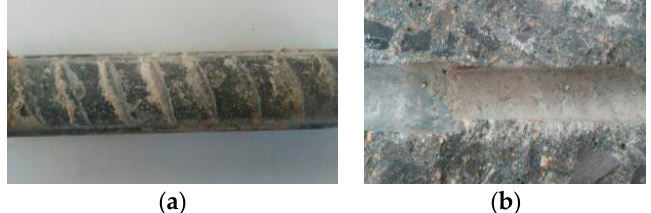
Figure 6. Slip surface of steel bar and concrete after failure: ( a ) steel bar surface; ( b ) concrete slip surface.